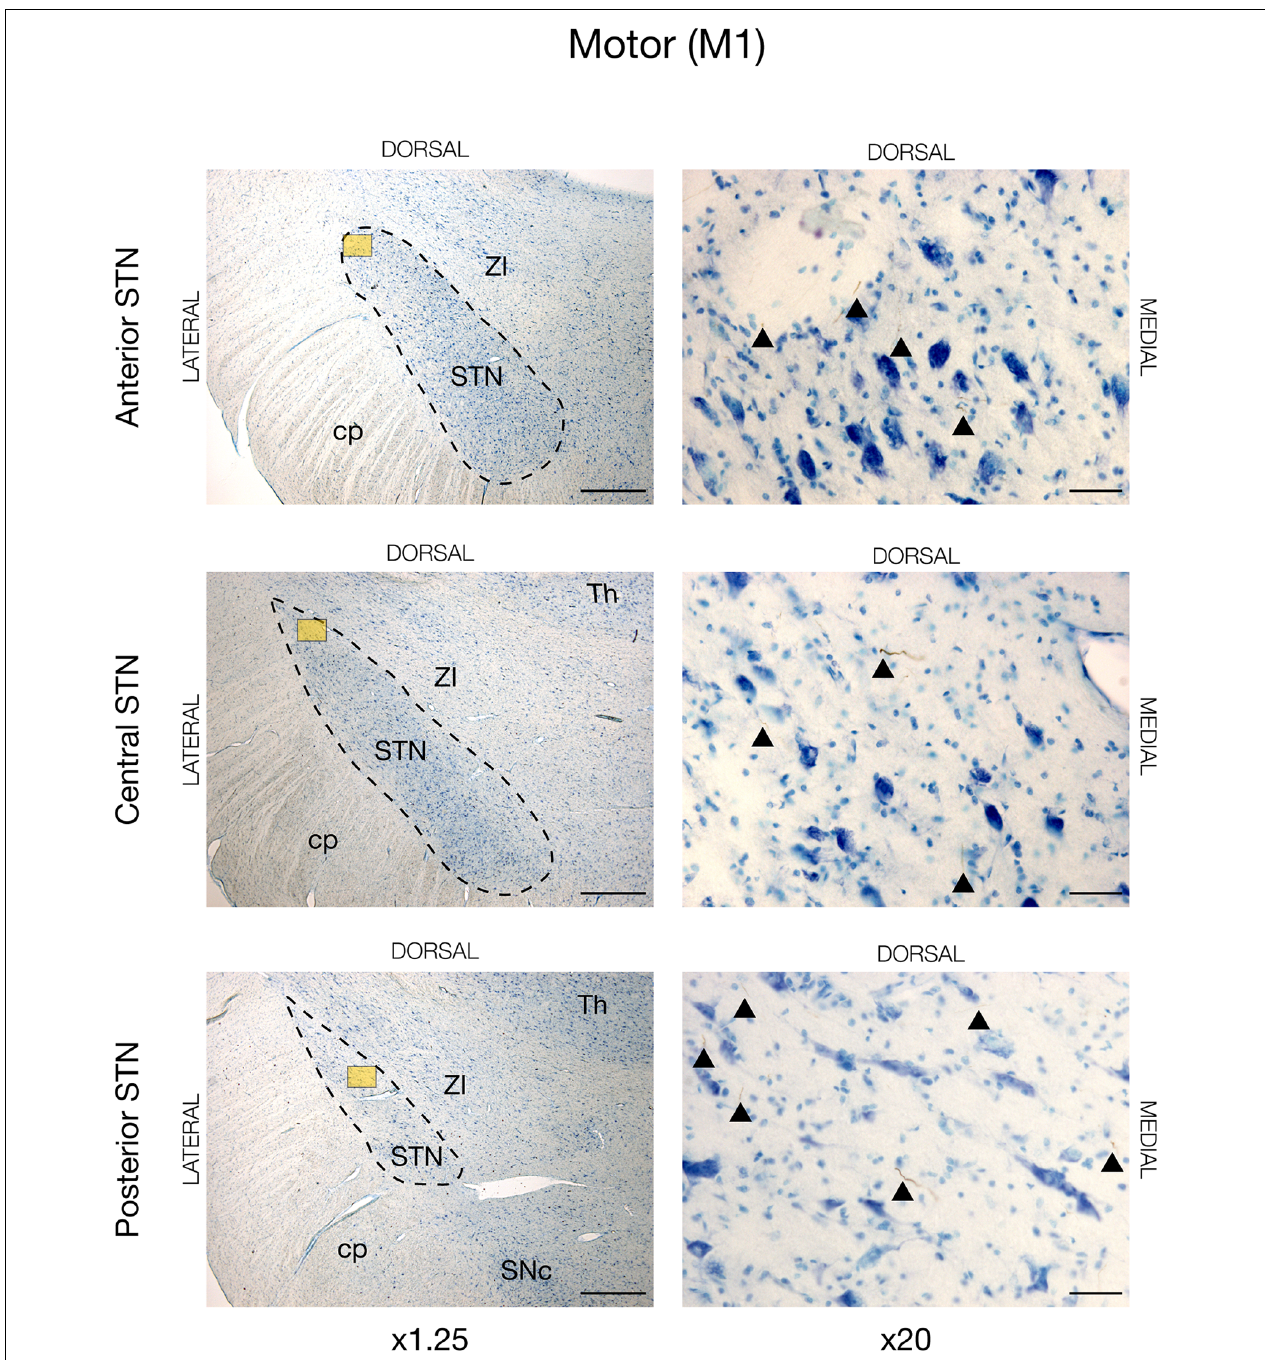
FIGURE 2 | Motor projections from the primary motor cortex (M1) injected with the neuronal tracer, BDA, as seen in the subthalamic nucleus, STN (dashed lines), of JBG-1. The three rows display the anterior, central, and posterior segment, respectively, which is depicted in x1.25 magnification for overview in the left column. Colored miniature windows are the areas seen in detailed x20 magnification in the right column. Arrowheads mark the golden-brown traversing fibers of varying diameter. ZI, zona incerta; cp, cerebral peduncle; Th, thalamus; SNc, substantia nigra pars compacta. Counterstaining with toluidine blue. Scale bars = 1 mm (x1.25) and 50 µ m